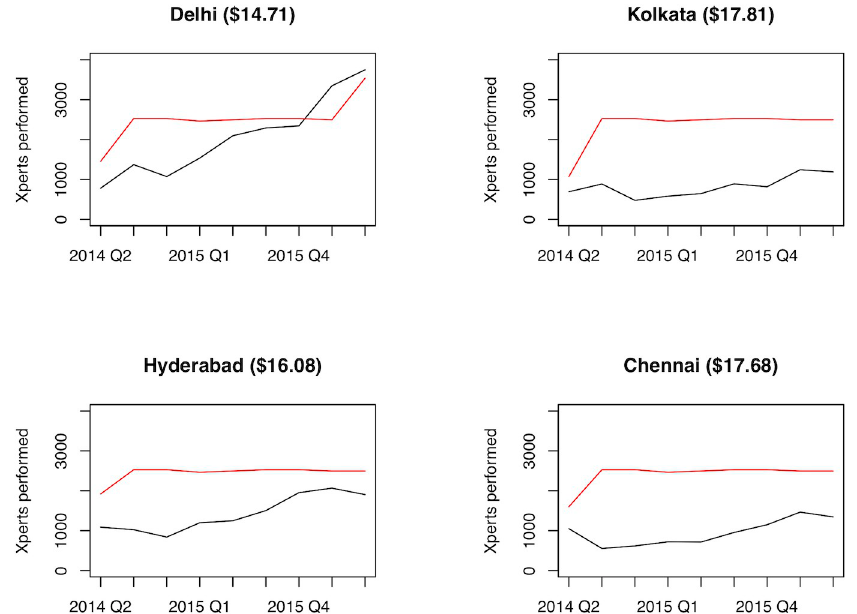
Fig 2. Quarterly workload data by city. Black indicates quarterly workload and red indicates quarterly testing capacity based on standard operating hours. Values in parentheses are the average workload-weighted Xpert per-test unit